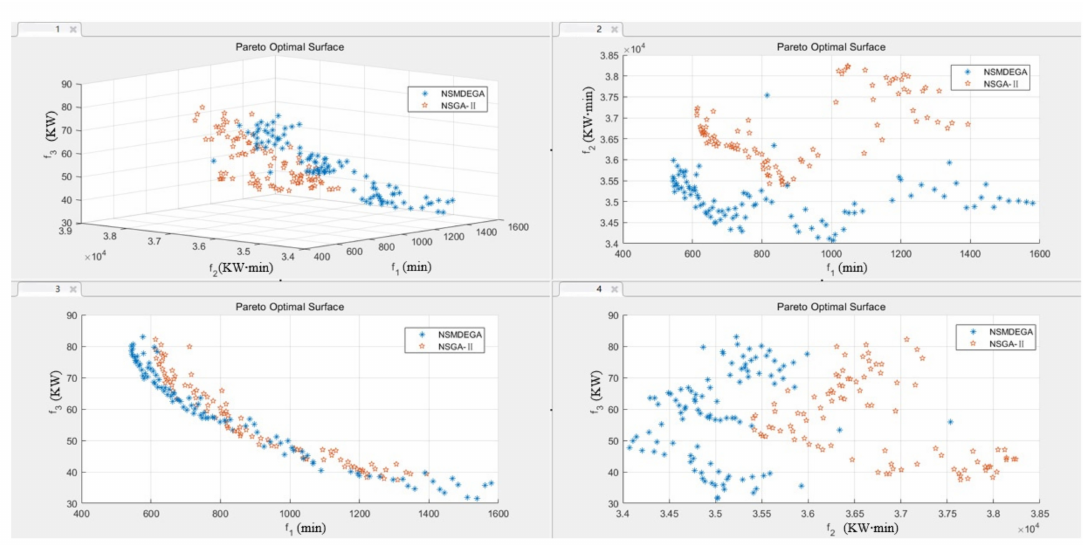
Figure 13. Distribution of the Pareto front from multiple perspectives for case